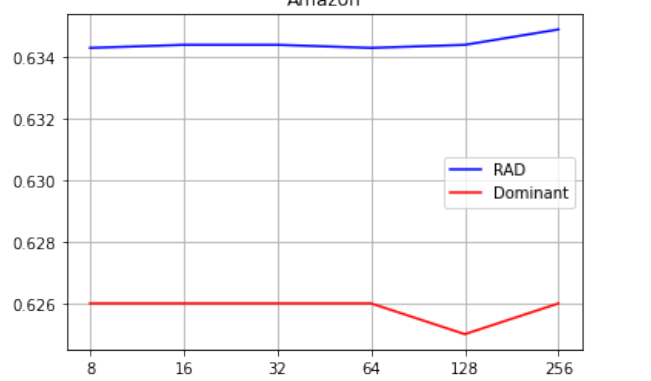
Figure 4. NodeAnomEn vs. DOMINANT.